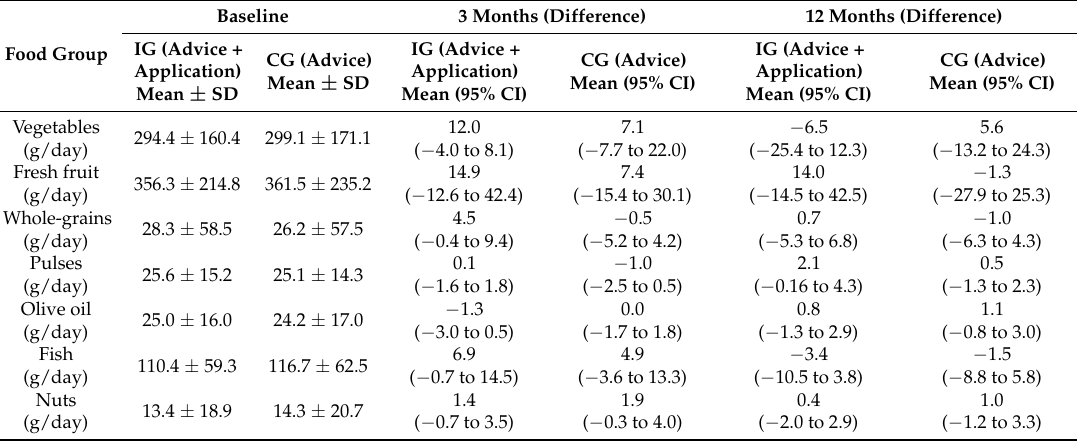
Table 4. Changes in food groups from baseline to 3 and 12